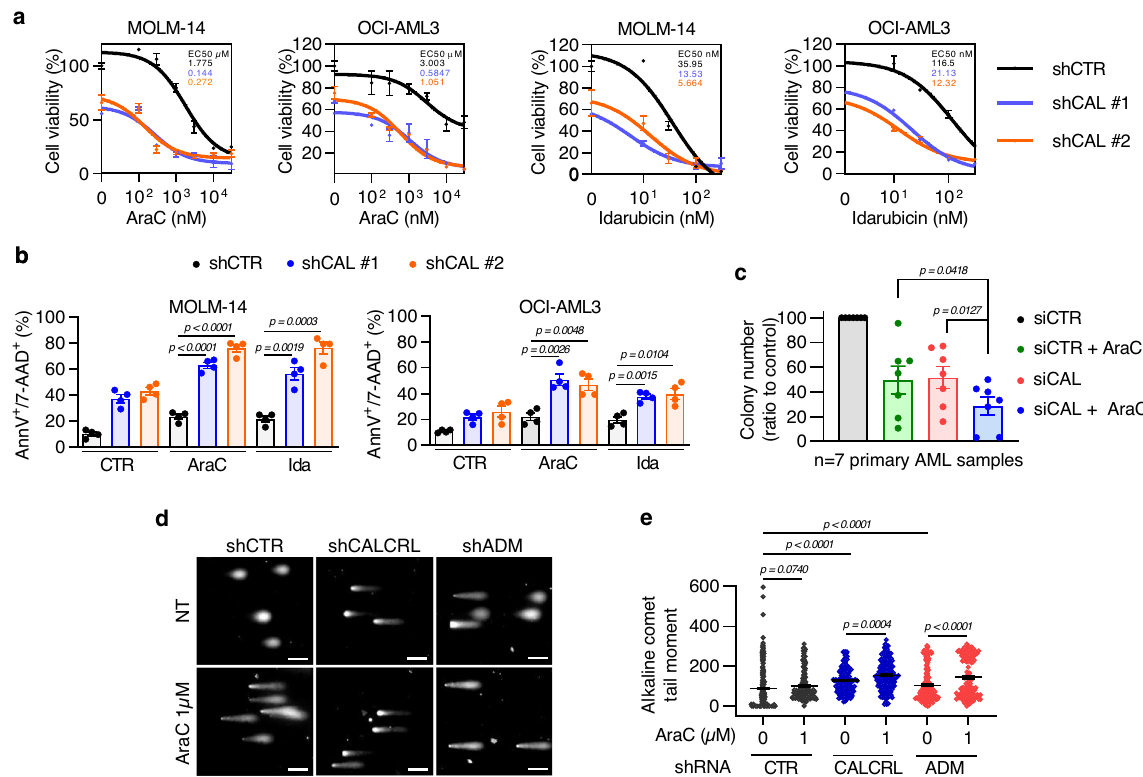
Fig. 5 Depletion of CALCRL sensitizes AML cells to chemotherapy through induction of DNA damages. a Four days after transduction, MOLM-14 or OCI-AML3 cells were treated with AraC or idarubicin for 48 h. Then cell viability was assessed by MTS assay and values were normalized to untreated condition ( n = 3 independent experiments). Curve fi t to calculate IC50 was determined by log (inhibitor) vs response (three parameters). b Graph shows the percentage of AnnV + or 7-AAD + cells. Four days after transduction, cells were treated with chemotherapeutic agents for 48 h before fl ow cytometry analysis ( n = 4 independent experiments, unpaired t- test). c Colonies in methylcellulose were counted 1 week after transfection of primary AML samples with siCTR or siCAL + /- 5 nM AraC ( n = 7 primary AML samples, paired t- est). d Detection of double strand breaks by alkaline comet assays in MOLM-14 cells untreated or treated 24 h with Ara-C (1 µ M). Representative pictures of nuclei in the same experiment. e Quanti fi cation of alkaline comet tail moments for one representative experiment (135 – 413 nuclei were analyzed for each treatment, unpaired t- test) out of four. Data are mean ±